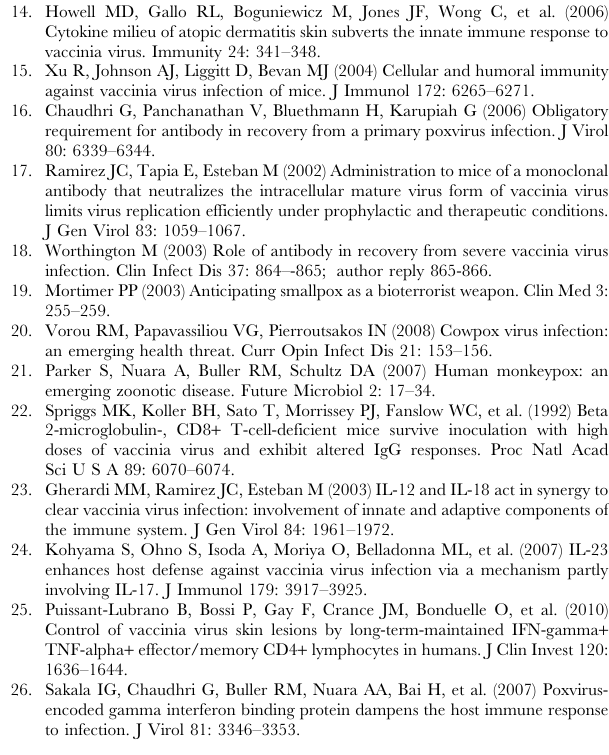
representative of the group. The lesion kinetic in Rag1 2 / 2 mice is shown to comparison purposes. (TIF) Figure S3 Functionality of splenocytes after passive transfer of WT T cells to Rag1 2 / 2 mice. (A) Flow cytometric analysis of the T cell-enriched population (CD3 + CD4 + to the left and CD3 + CD8 + to the right) derived from spleens of C57Bl/6 mice. Numbers shown are percentage of total cells expressing both markers. (B) Rag1 2 / 2 mice were passively transferred with different combination of T cells from WT (C57Bl/6) mice. At days 10 and 15 p.i., spleens of these mice were pooled, made into single-cell suspension and stained for intracellular IFN- c . Data are shown as histograms. Gray-filled histograms represent isotype controls. (C) The percentage of IFN- c + splenocytes in the different groups is shown graphically.